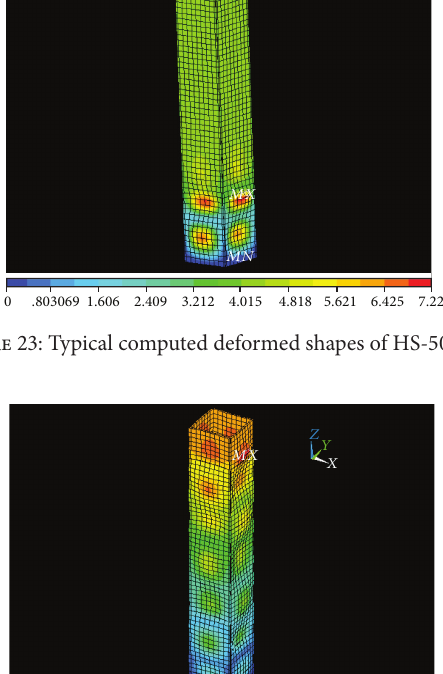
Figure 15. When increasing the spacing of FRP strips